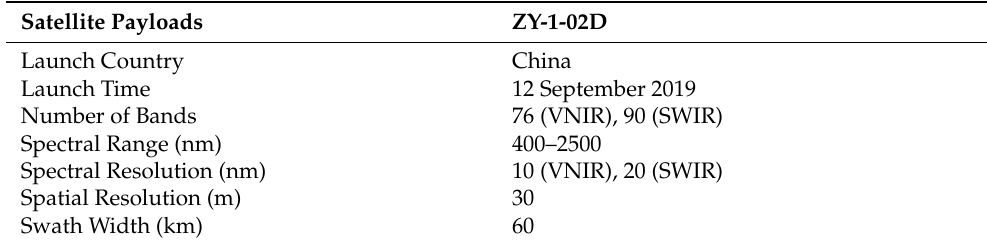
Table 1. ZY1-02D satellite payloads